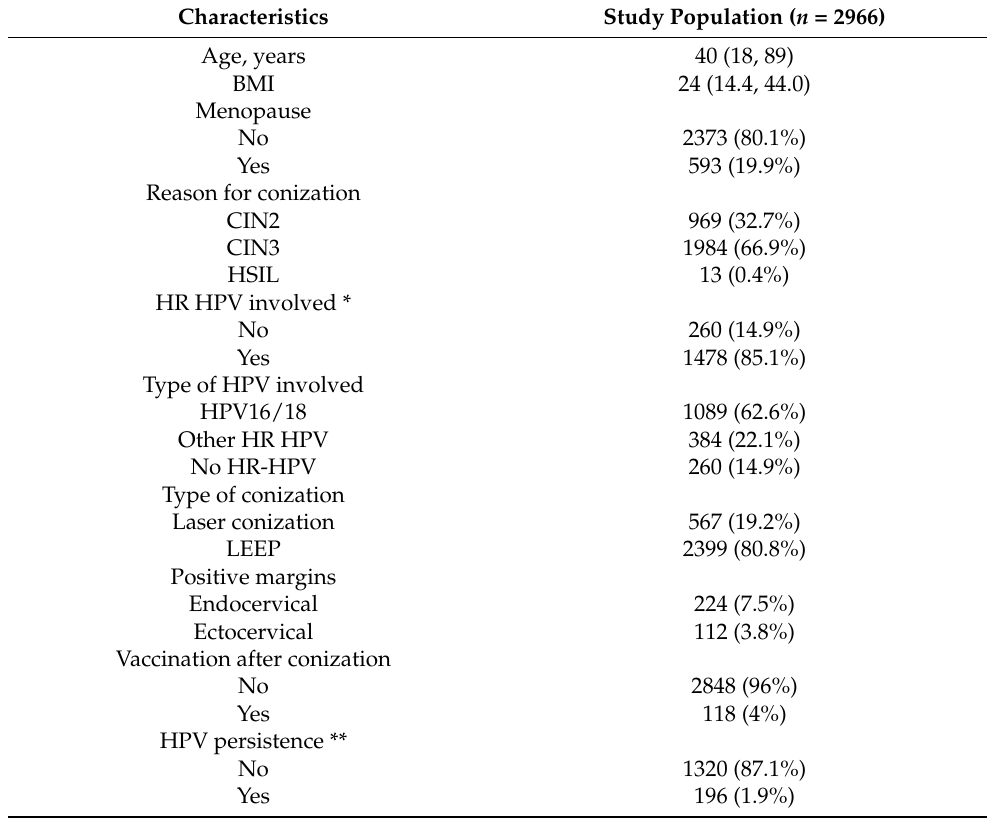
Table 1. Baseline characteristics of the population.